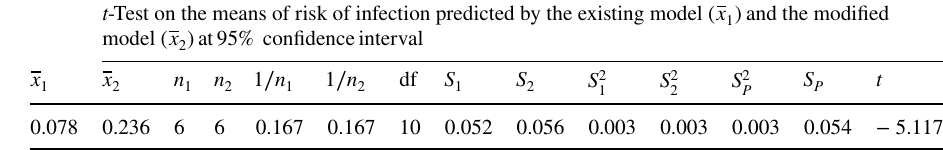
ẍ 1 = mean risk of infection predicted by existing model; model; n 1 , n 2 = number of pathogens examined for the existing and the modified model, respectively. df = degree of freedom; s 1 , s 2 = standard deviations of risk of infection values of the existing and the modi- fied model, respectively; t cal = calculated t -distribution value. Where From the t -distribution table, t , 0.025, 10 = 2.228